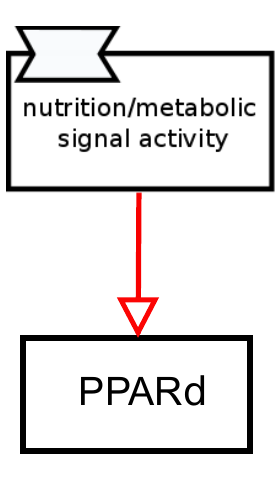
Figure 2.15: The Activity Flow glyph for positive influence .